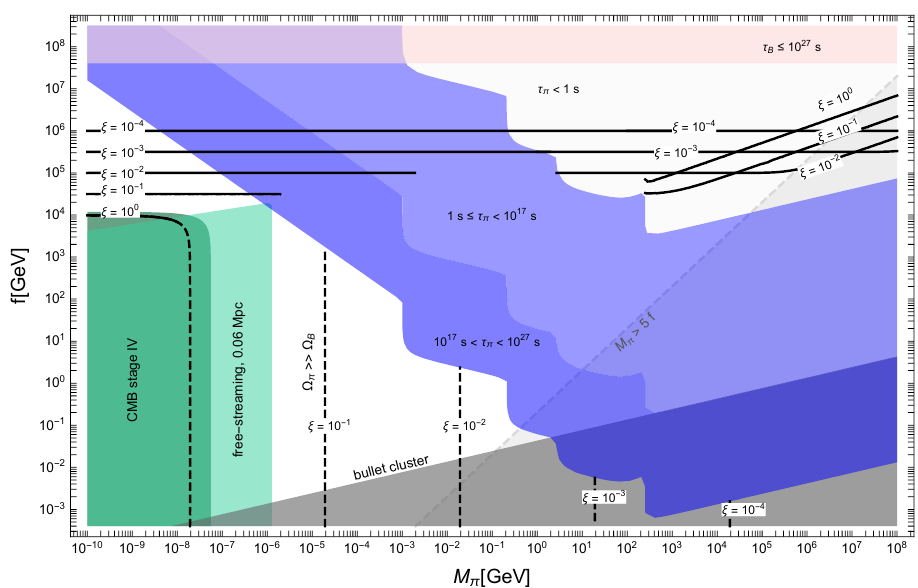
Figure 2. Parameter space of (secluded) dark QCD as a function of M π and f , with baryon mass fixed to M = 10 f , N = 3 and Λ = M = 2 . 4 × 10 18 GeV . On the black solid isolines B F 5 Pl DM abundance is reproduced by dark baryons, while on the black dashed isolines by dark pions. Regions of stability are as in figure